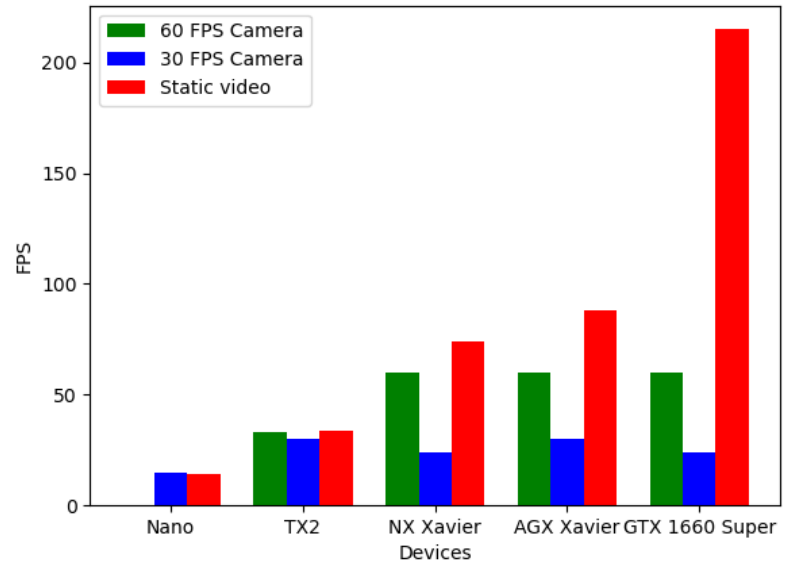
Figure 7. Achieved frame rates per device and test.